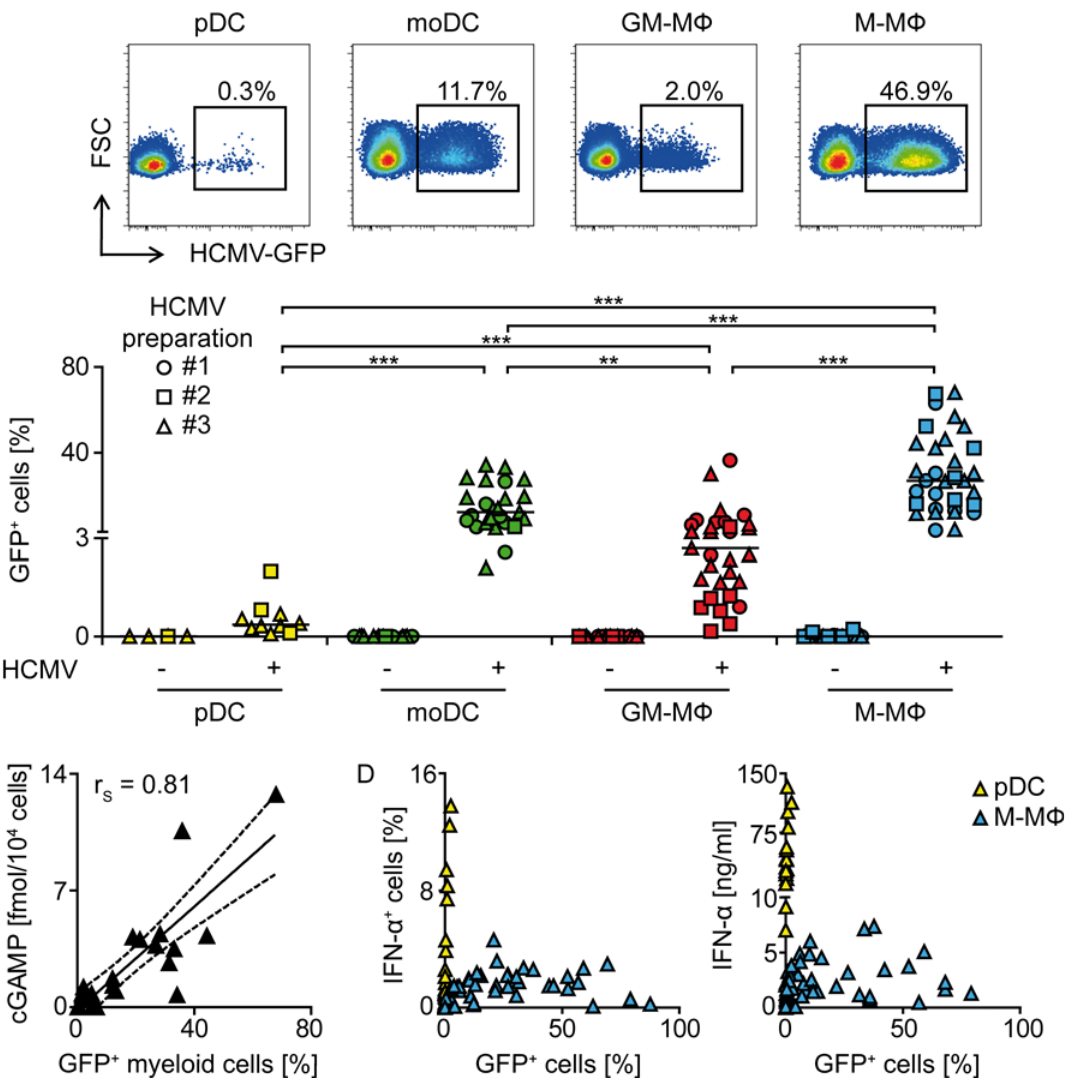
Fig 8. Upon HCMV-GFP infection, GFP + cells are more abundant in monocyte-derived cells than in pDC. (A, B) pDC, moDC, GM-CSF M Φ , and M-CSF M Φ were infected with three independently produced HCMV-GFP preparations (#1, #2, and #3) at MOI 3 for 24 h and percentages of HCMV-GFP + cells were analyzed by flow cytometry. (C) pDC, moDC, GM-CSF M Φ , and M-CSF M Φ were infected with HCMV-GFP and percentages of GFP + cells as well as cGAMP synthesis were determined by FACS analysis and a HPLC-MS/MS method, respectively. Percentages of GFP + cells (x-axis) were blotted against the amount of cGAMP synthesized (y-axis) from the same cultures for all different cell subsets in one blot and the Spearman correlation (r S ) between the factors was determined. (D) pDC and M-CSF M Φ were infected with HCMV-GFP at varying MOI between 0.1 to 30 and percentages of GFP + cells (x-axis) were blotted against percentages of IFN- α + cells or IFN- α contents of cell-free supernatants of the same cultures (y-axis). Median of 8 – 30 (B) or values from 3 – 7 (C) and 14 – 42 (D) different donors. ** : p (cid:1) 0.0013, *** : p (cid:1) 0.00031 one-tailed paired Wilcoxon signed rank test was used for statistical analyses between monocyte-derived cell subsets, because the subsets were derived from monocytes of the same donors. In contrast, pDC were derived from different donors. Therefore, statistical analysis between pDC and one of the monocyte-derived cell subsets was performed using one-tailed unpaired Mann-Whitney